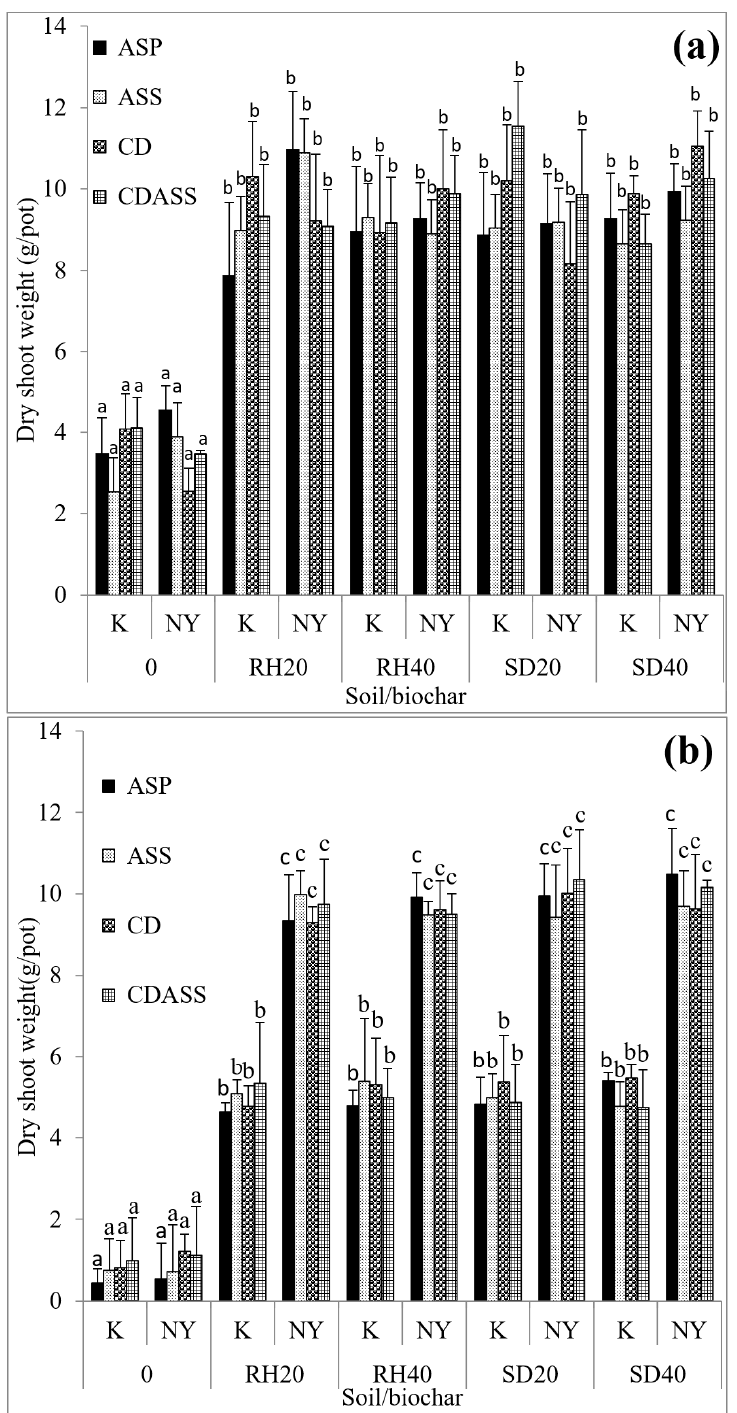
Figure 1. Dry shoot weight of the maize grown with the different amendments in the ( a ) first and ( b ) second growing seasons. K: Keta series, Ny: Nyankpala series, ASP: Ammonium sulfate fertilizer, ASS: Ammonium sulfate embedded into the biochar, CD: Cow dung, CDASS: Cow dung + Ammonium sulfate embedded into the biochar, RH20: 20 t ha − 1 Rice husk biochar, biochar. Values for dry shoot weight with same letter(s) under the same planting season were not significantly different at p